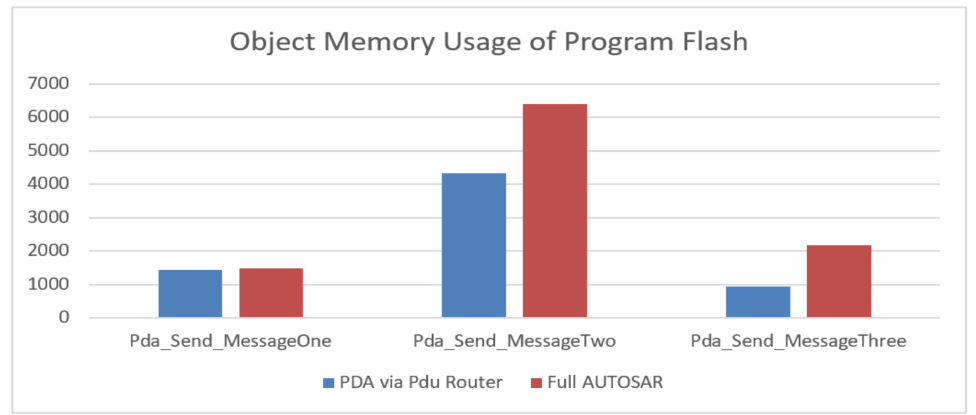
Figure 18. Comparisons on object memory usage of program